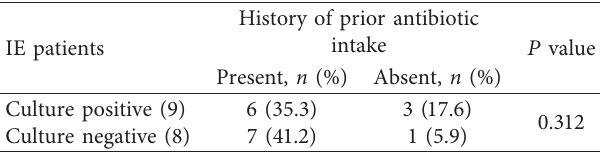
Table 7: Comparison of culture-positive and culture-negative IE patients with history of prior antibiotic intake ( n � 17). IE